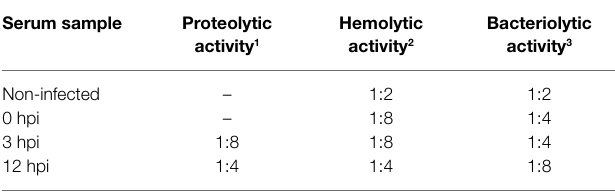
TABLE 3 | Proteolytic, hemolytic and bacteriolytic activity of eel serum before and after V. vulnificus infection. Serum